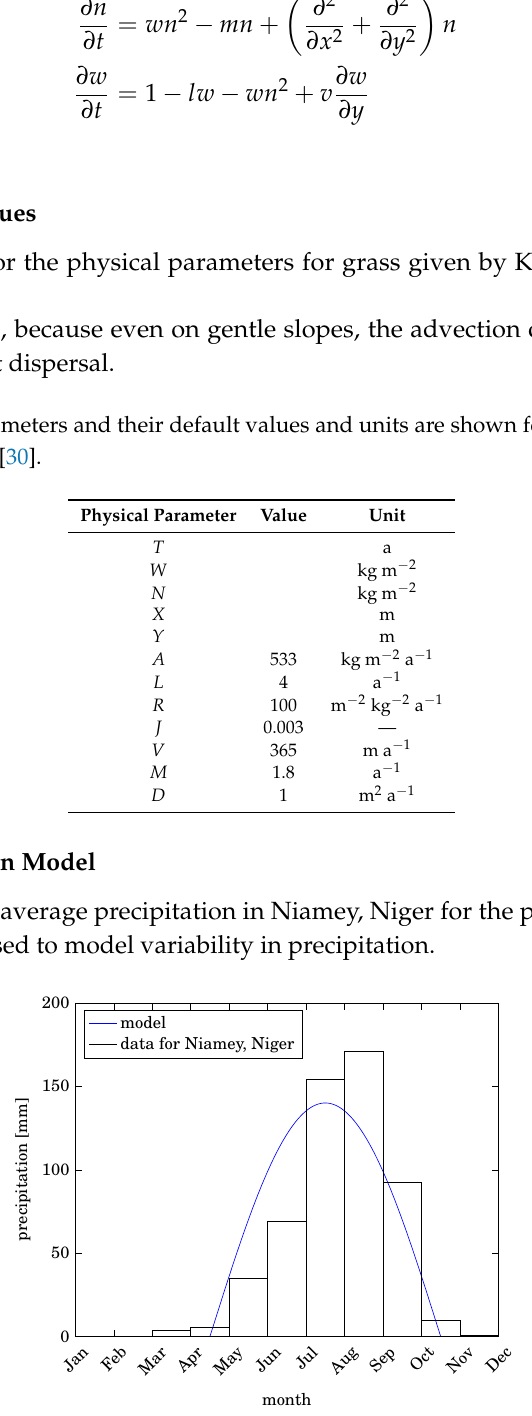
Figure A2. Average precipitation for Niamey, Niger (1961–1990) and the corresponding model are shown. Precipitation data retrieved from [52]. The geographic position of the station is N13 ◦ 29 (cid:48) , E2 ◦ 10 (cid:48)